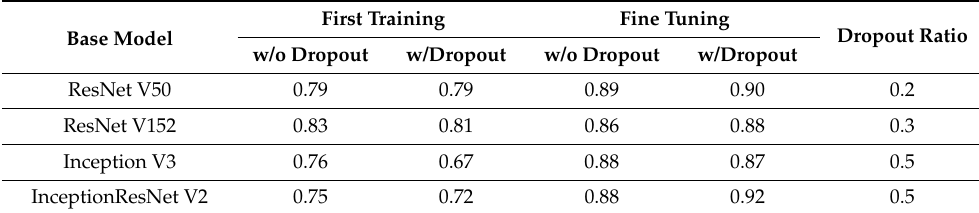
Table 3. The accuracy of the various CNN models used as the base models.